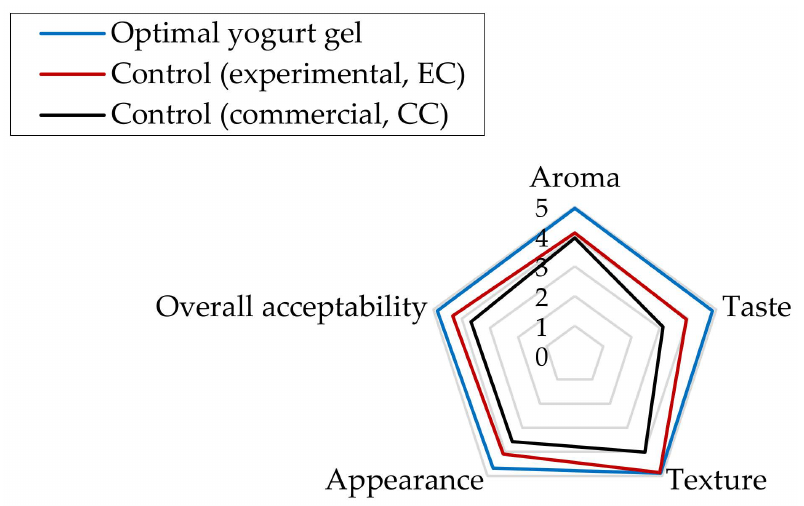
Figure 6. The organoleptic properties of the optimal yogurt gel compared two control samples (experimental and